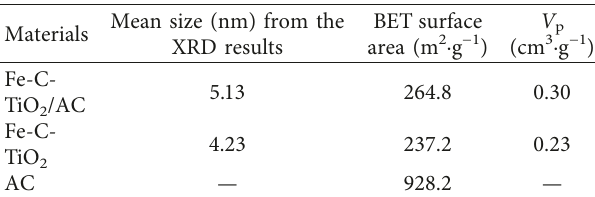
2 /AC, Fe-C-TiO 2 , and TiO 2 .